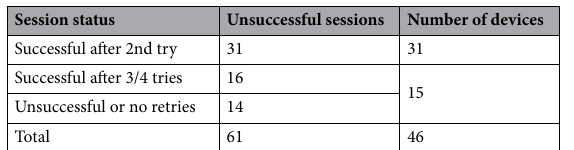
Table 6. Breakdown of the failed remote